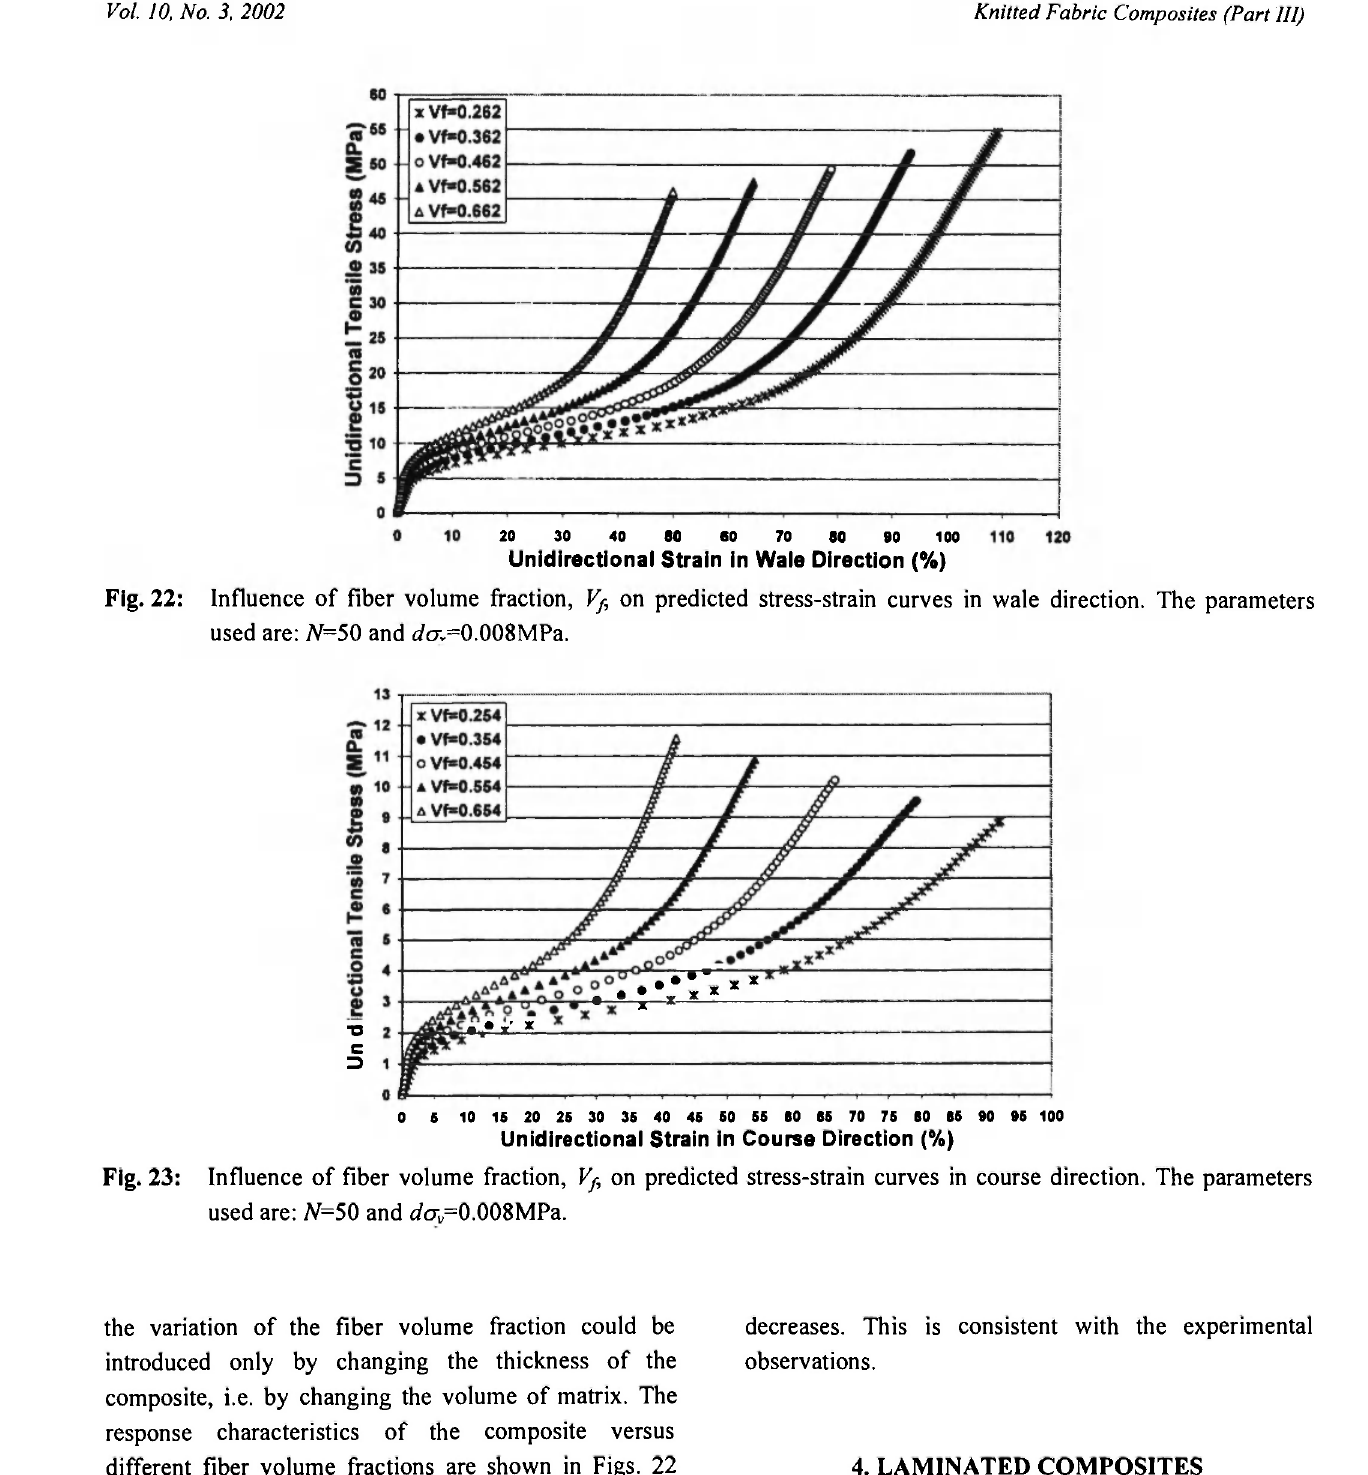
Fig. 23: Influence of fiber volume fraction, V fi on predicted stress-strain curves in course direction. The parameters used are: N= 50 and tfo- v